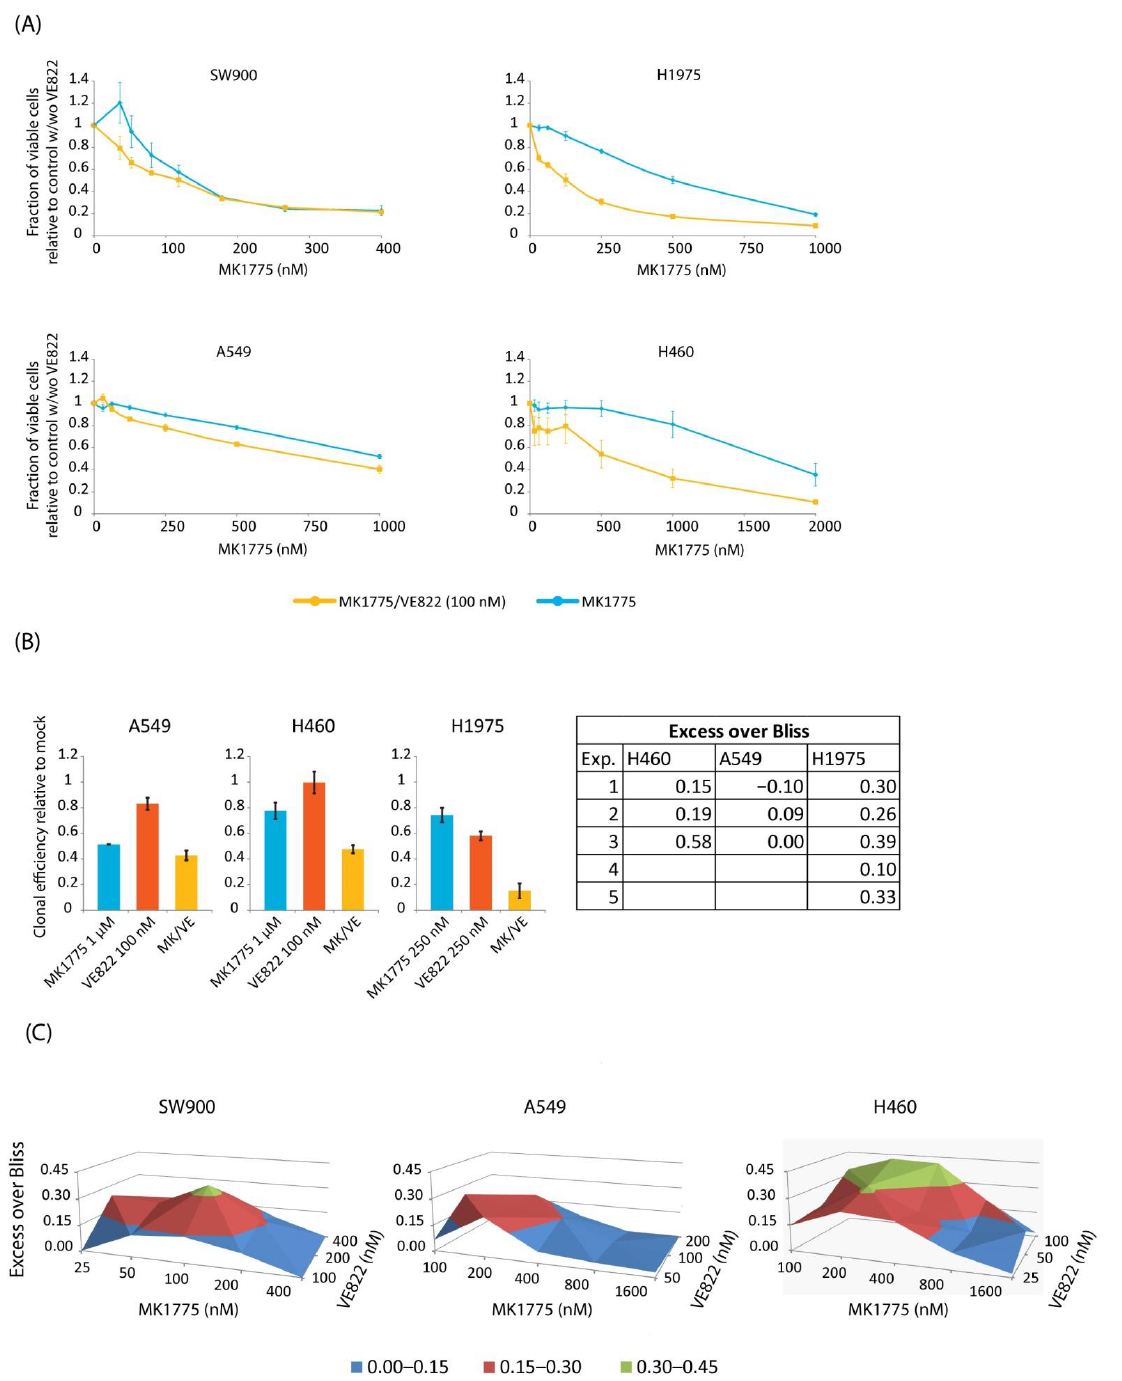
Figure 4. Cytotoxic effects of combined WEE1/ATR inhibition vary between lung cancer cells. ( A ) CellTiter-Glo viability assays of SW900, H1975, A549, and H460 cells from the same experiments as in Figure 2A, treated with MK1775 together with 100 nM VE822 (yellow) compared to the results of MK1775 alone (blue) shown in Figure 2A. Cell viability is normalized to mock for MK1775 alone and to VE822 alone for the combination. The fraction of viable cells after treatment with 100 nM VE822 alone was approximately 80% for A549 and H1975, 90% for SW900, and 60% for H460 cells. Error bars: SEM ( n = 3). ( B ) Clonogenic survival assays of A549, H460, and H1975 cells treated with MK1775 and/or VE822 at the indicated concentrations for 24 h. Clonal efficiency relative to untreated cells is shown. Table to the right shows the difference between the measured effect and the expected additive effect (excess over Bliss) for the combined treatment in each experiment ( p < 0.05 for H1975 cells). Error bars: SEM ( n ≥ 3). ( C ) Excess over Bliss from CellTiter-Glo viability assays performed on SW900, A549, and H460 with a matrix of combinations of MK1775 and VE822. Cells were treated for 48h with inhibitors and assayed three days after drug